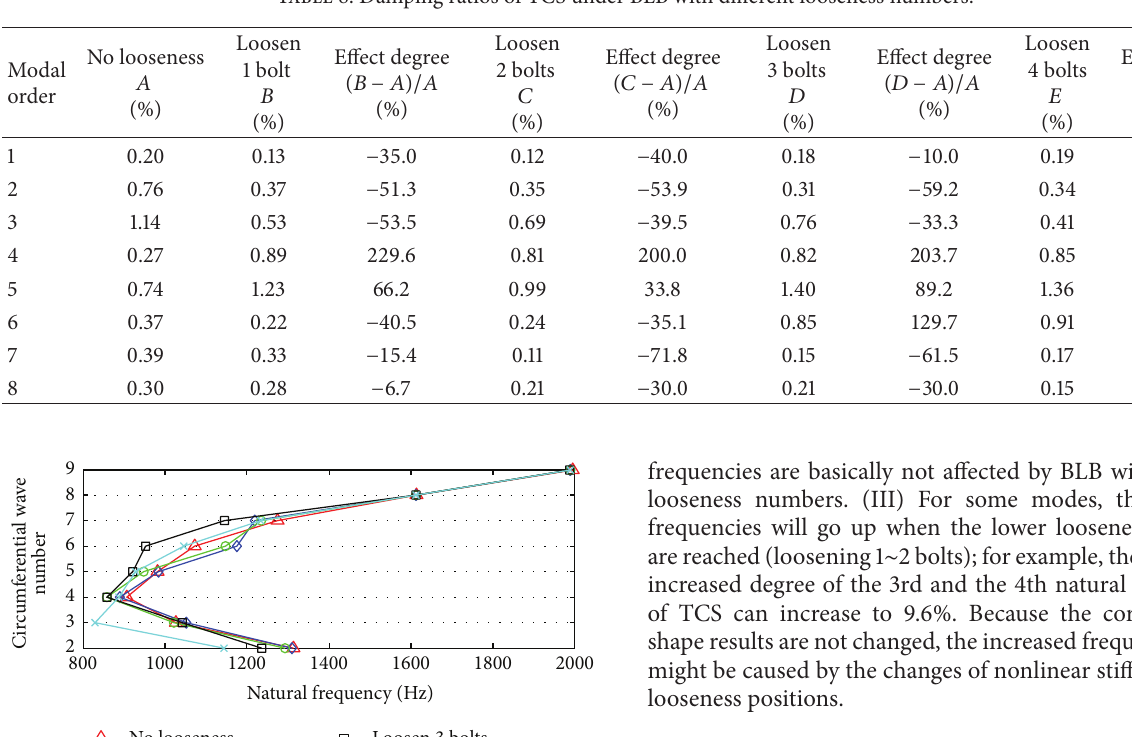
Table 8: Damping ratios of TCS under BLB with different looseness numbers.